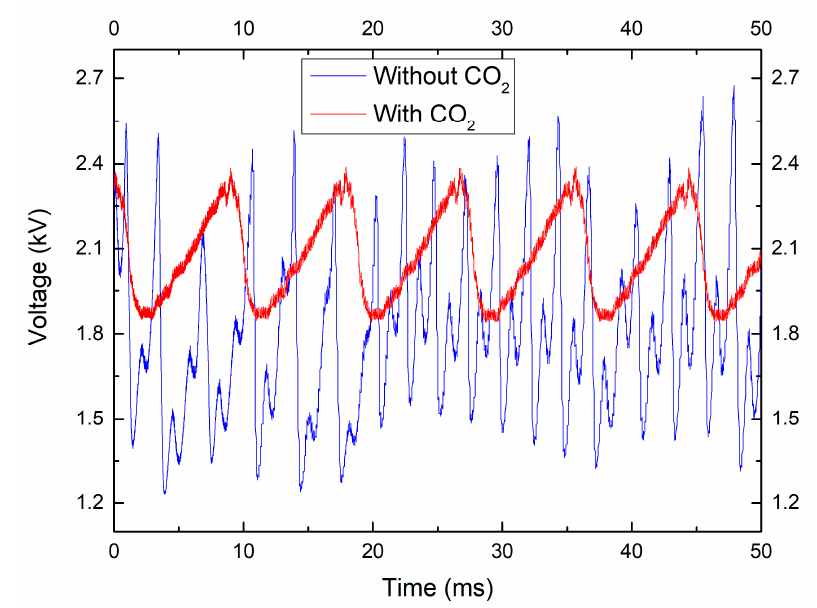
Figure 10. Voltage waveform of the discharge with 15% CO 2 and without CO 2 .